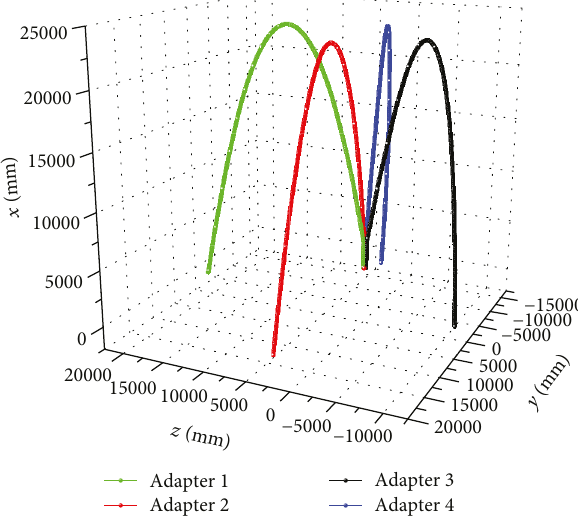
Figure 11: The three-dimensional trajectory of